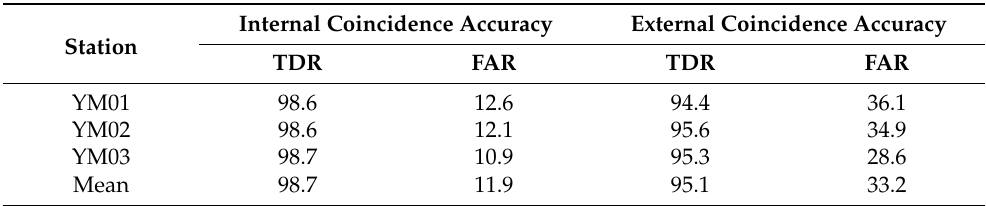
Table 4. Statistical results of TDRs and FARs of internal and external coincidence accuracies of the nonlinear method-based rainfall forecast model at the three stations.